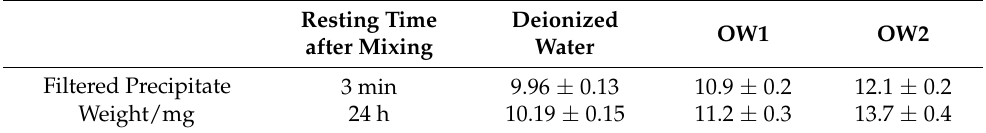
Figure 1. The weight of the precipitate recovered by filtration of the solid CaOx aqueous suspensions obtained after 3 min ( a ) or 24 h ( b ) by mixing calcium chloride and sodium oxalate solutions. The different aqueous media used as solvent to prepare the solutions are indicated (D.I. water stands for deionized water). Bars represent the mean value ± standard deviation (**** p < 0.0001; *** p < 0.001). Table 2. Average weight (± standard deviation) of the precipitate recovered by filtration of the solid CaOx aqueous suspensions obtained by mixing the calcium chloride and sodium oxalate solutions, which were prepared using the water indicated.